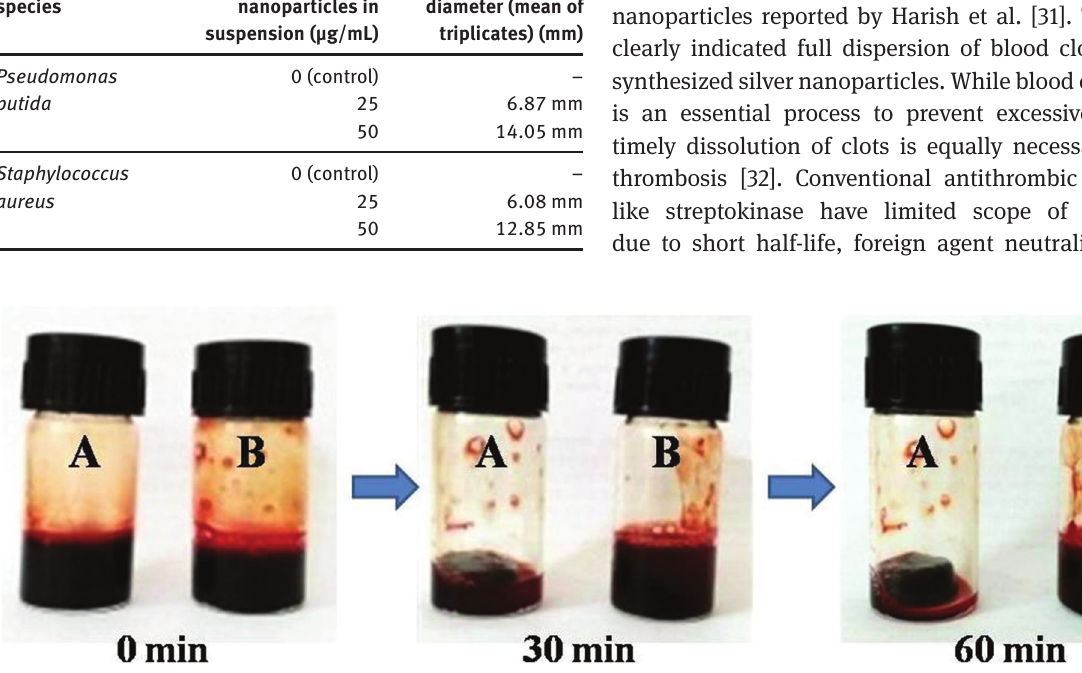
Table 1: Result of antibacterial assay. Tested bacterial